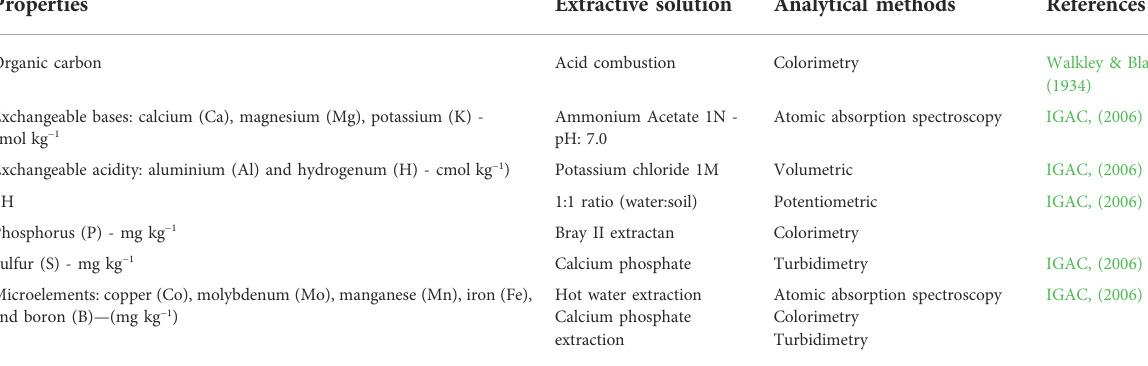
TABLE 3 Analytical methods used for the determination of soil chemistry properties.